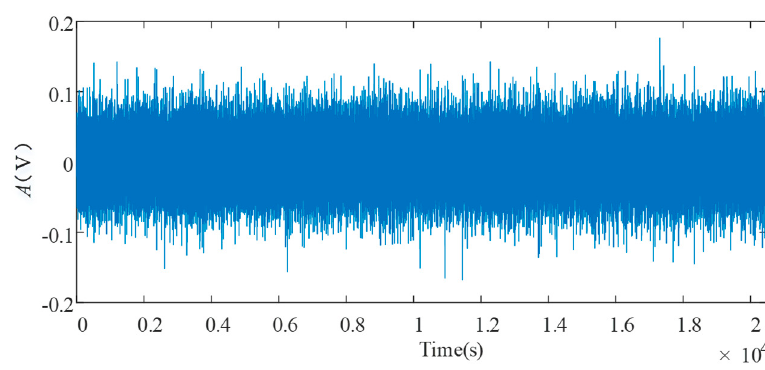
Figure 18. Test signal in the healthy condition.